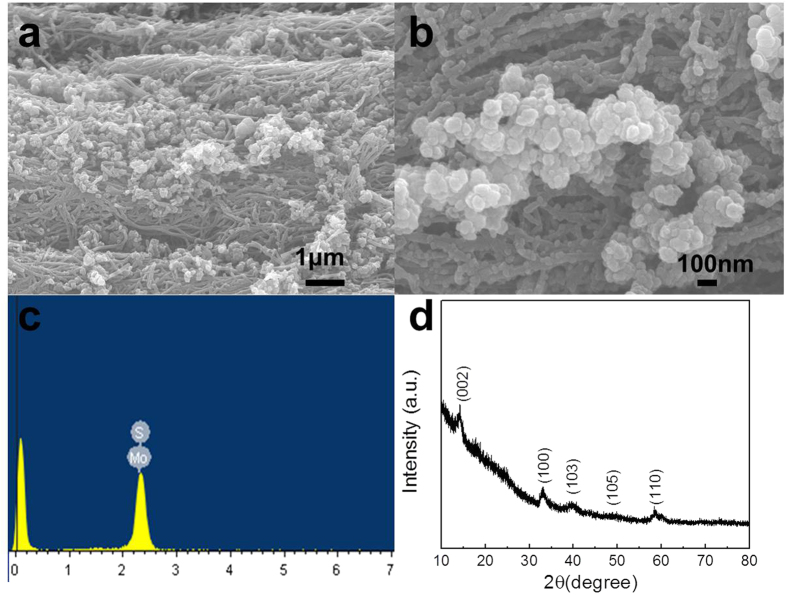
SEM images (a, b) of PPy fiber and MoS2 particles,EDS analysis and XRD pattern (c, d) of MoS2 particles.